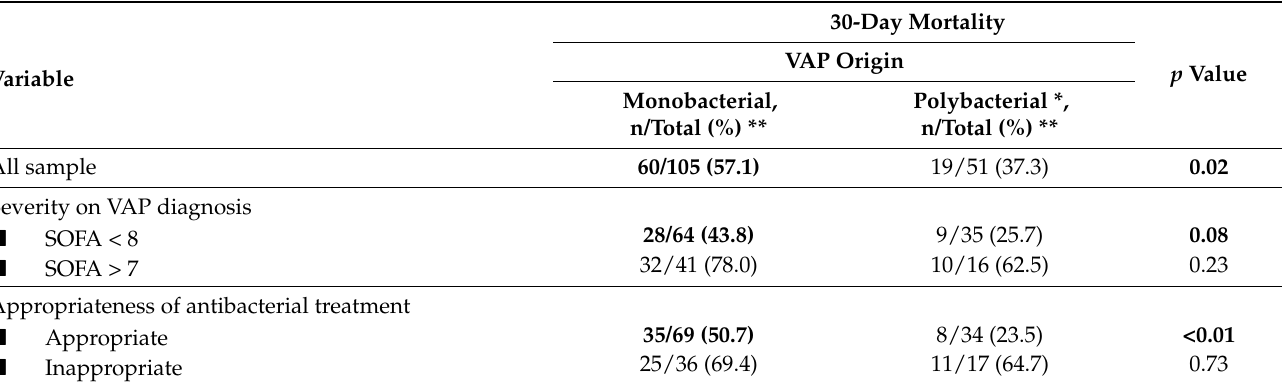
Table 2. The 30-day mortality of mono- and polybacterial cases of VAP due to